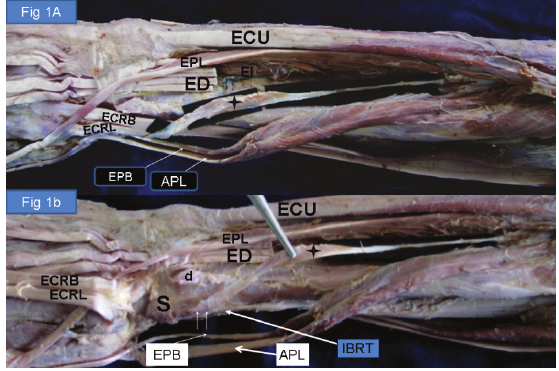
Figure 1 - The extensor compartment of the right forearm and hand, showing the anomalous muscle. A: abductor pollicis longus (APL); exten- sor carpi radialis brevis (ECRB); extensor carpi radialis longus (ECRL); extensor carpi ulnaris (ECU); extensor digitorum tendons (ED); extensor indicis (EI); extensor pollicis brevis (EPB); extensor pollicis longus (EPL); indicates the anomalous muscle. B: The extensor carpi radialis brevis and the extensor carpi radialis longus tendons were cut to show the insertion site of the anomalous muscle. APL; dorsal tubercle of Lister (d); extensor carpi radialis brevis tendon reflected (ECRB); extensor carpi radialis longus tendon reflected (ECRL); extensor carpi ulnaris (ECU); extensor digitorum tendons (ED); extensor pollicis brevis (EPB); extensor pollicis longus (EPL); insertion of brachioradialis tendon (IBRT); styloid process of radius (S); indicates the anomalous muscle. The white arrows indicate the insertion site of the anomalous